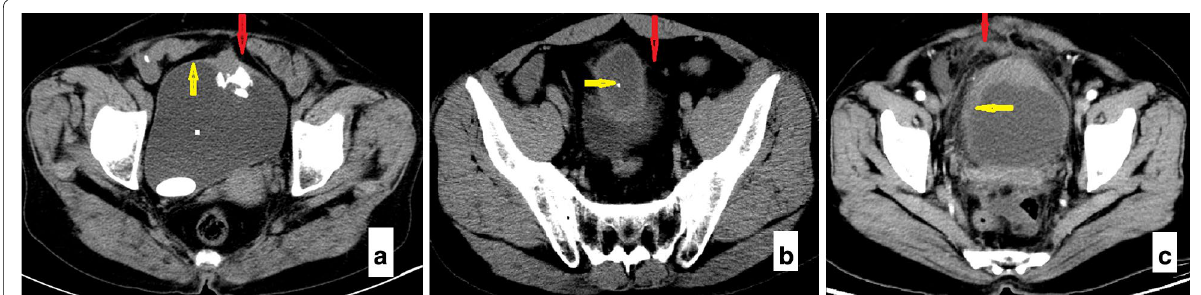
Fig. 1 Computed tomography (CT) manifestations of a urachal carcinoma and a benign urachal mass. a On an axial view of a urachal carcinoma, the red arrow indicates the Retzius space without fat infiltration, and the yellow arrow indicates a lack of thickening of the surrounding bladder wall. b On an axial view of a urachal carcinoma, the red arrow indicates the Retzius space without fat infiltration, and the yellow arrow indicates calcifica- tion in central lesions. c On an axial view of a benign urachal mass, the red arrow indicates fatty infiltration of the Retzius space, characterized by enhancements of some patches or strips and vague indications of fat surrounding the lesions, and the yellow arrow indicates diffuse thickening of the bladder wall not only around the lesions but also across the whole bladder dome and two side walls, with the peripheral wall gradually thinning to